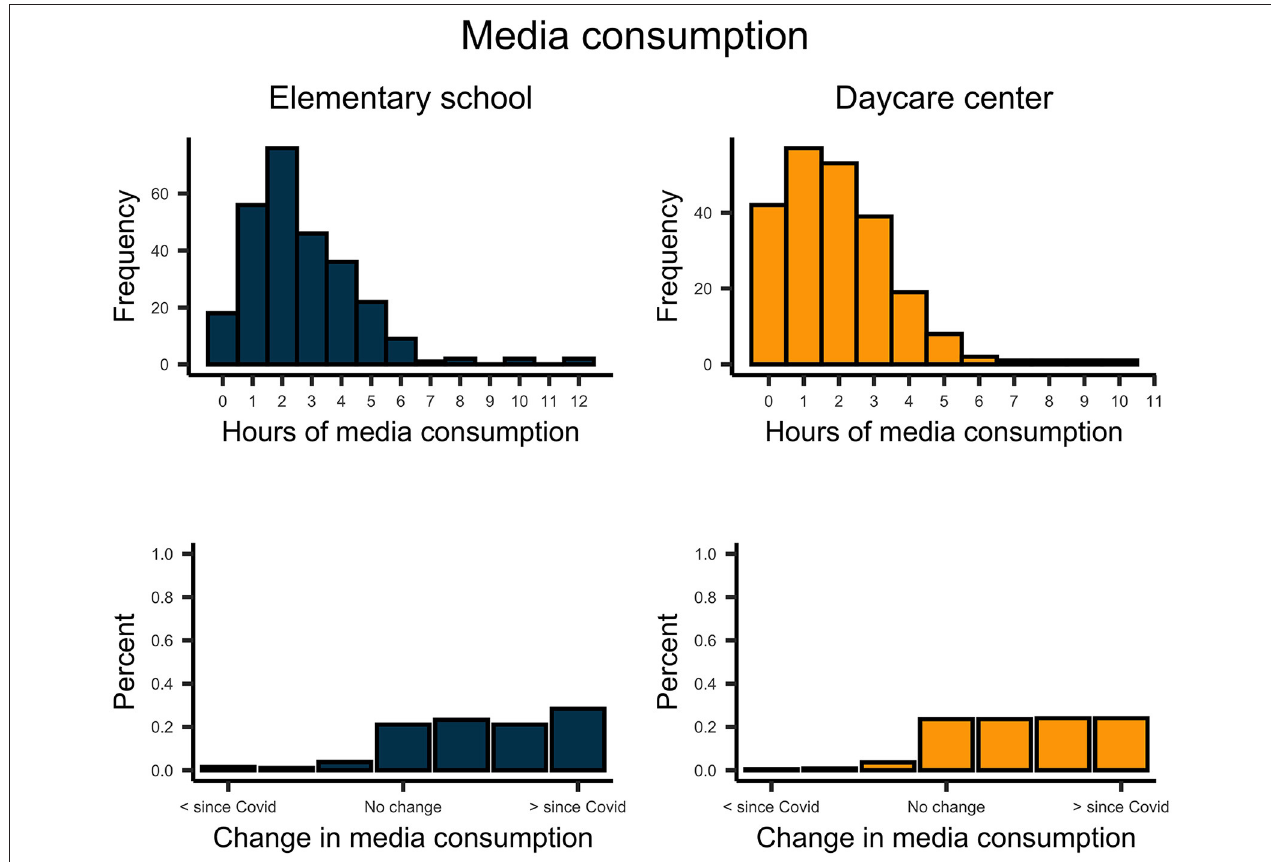
FIGURE 9 | Upper plots indicate the daily number of hours school- and preschool-aged children spent for media consumption. Lower plots indicate the change in the media consumption by children since the COVID-19